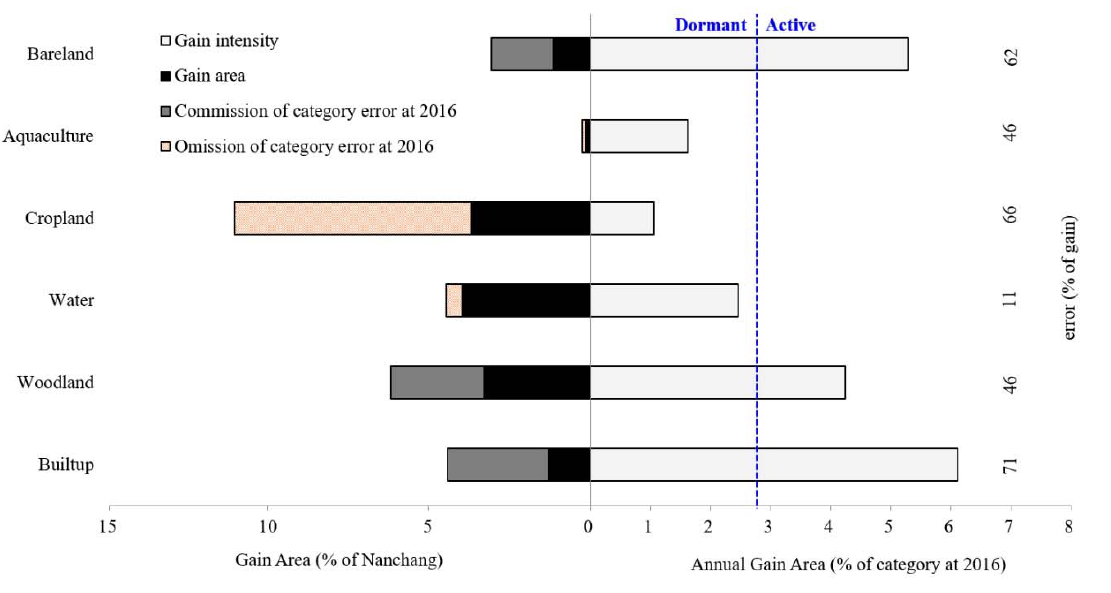
Figure 10. Category level gains during 2008–2016.